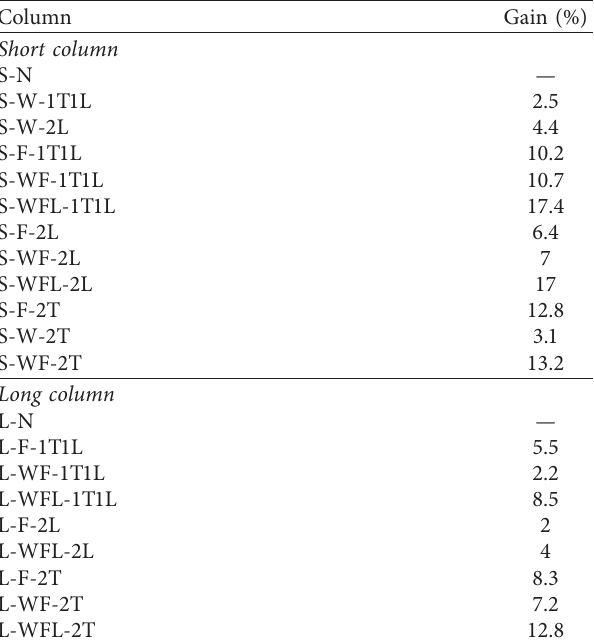
Figure 11: Curves for the (a) short columns,1T1L/2T/T/N, and (b) long columns, 1T1L/2T/T/N. Table 6: Component growth